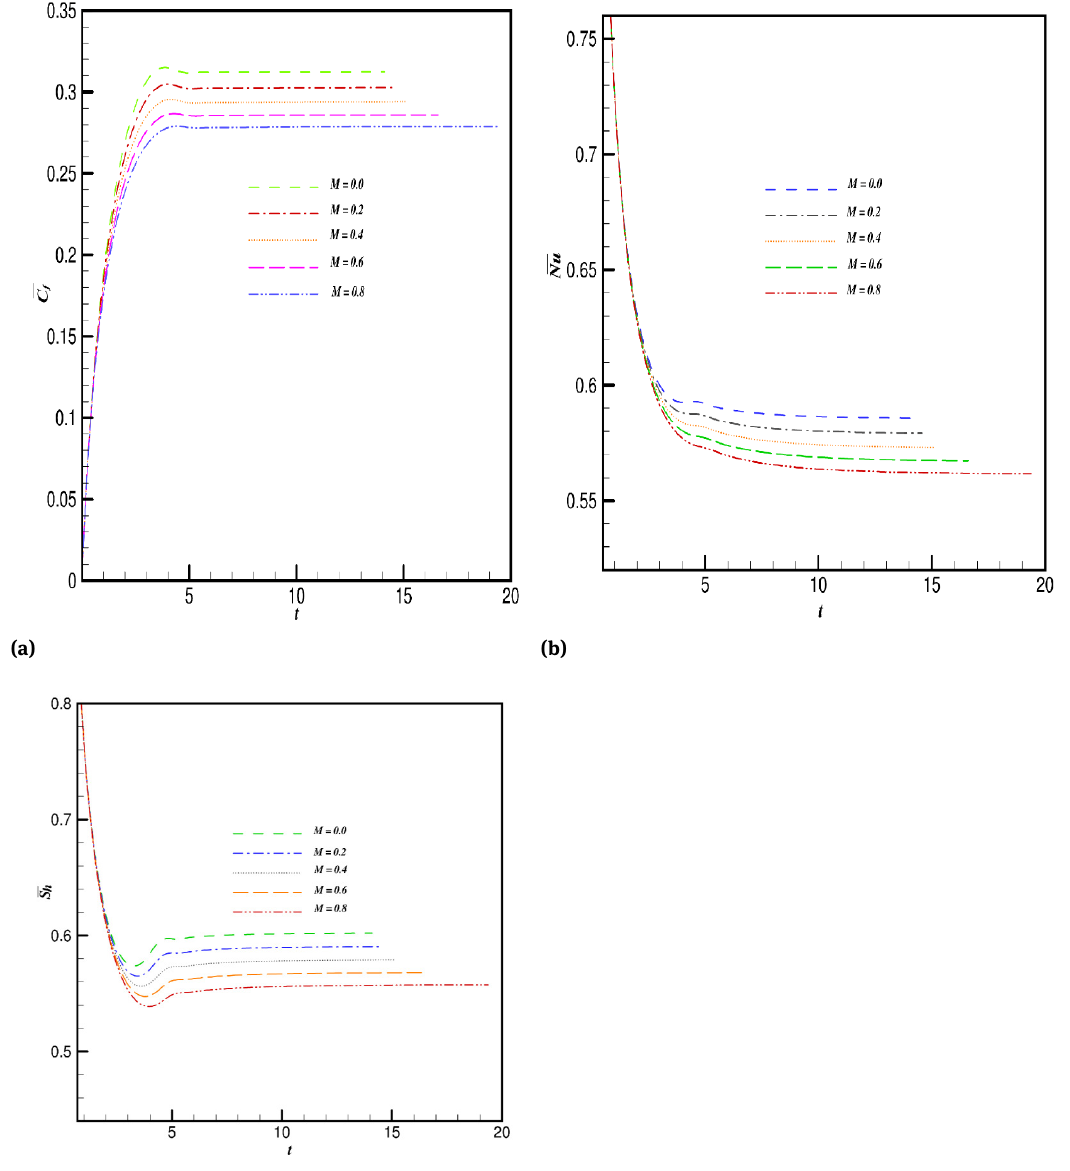
Figure 15: Profiles of average ( a ) skin friction coefficient, ( b ) Nusselt numer and (c) Sherwood number for fixed Sc = 0.6 , Pr = 0.7 , Bu = 1.0 , Kr = −0.2 , Nr = 2.0 , K 1 = 1.0 , Ec = 0.1 .